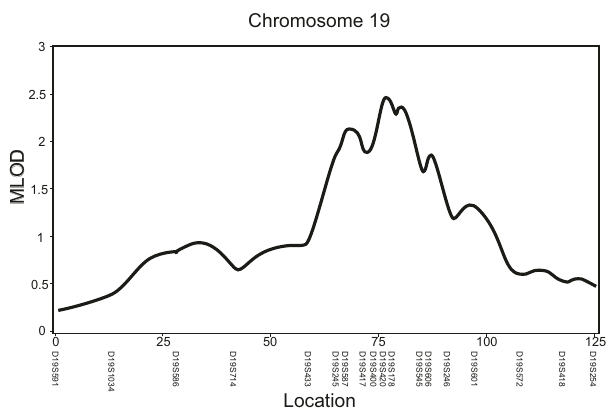
Figure 2 Chromosome 19 multipoint lod score versus genetic dis- tance (cM). Also indicated below the cM scale are the poly- morphic